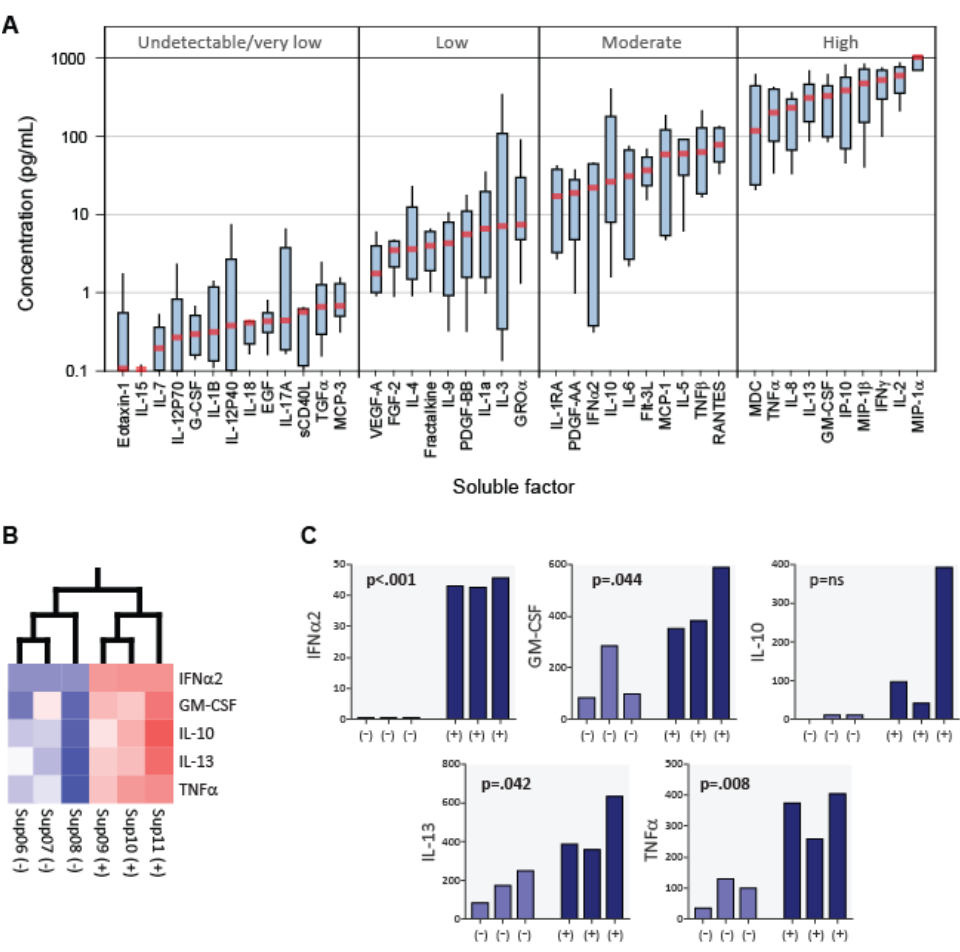
Figure 5. Cytokines in CD8+ T cell culture supernatants . Multiplex cytokine assays were performed on CD8+ T cell culture supernatants having <50% ( − , n = 3) and >50% (+, n = 3) anti-HIV-1 activity. ( A ) Boxplots are shown for the 42 soluble factors measured, ranked in order of increasing median concentration. Boxes denote medians (red lines) and interquartile ranges, and whiskers denote 10th and 90th percentiles for analyte. ( B ) Among the 42 soluble factors evaluated, principal component analysis (PCA) identified 5 cytokines that distinguished the 2 groups. ( C ) Bar plots show the concentrations (pg/mL) of the distinguishing cytokines for each CD8+ T cell culture supernatant.